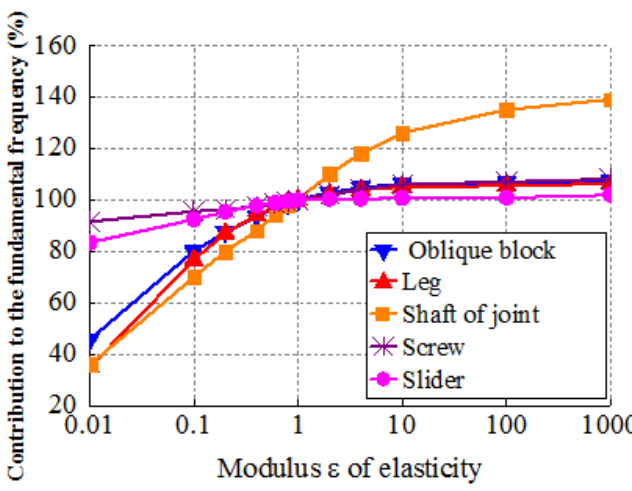
Figure 5. Effects of each component on the stiffness of the entire mechanism.